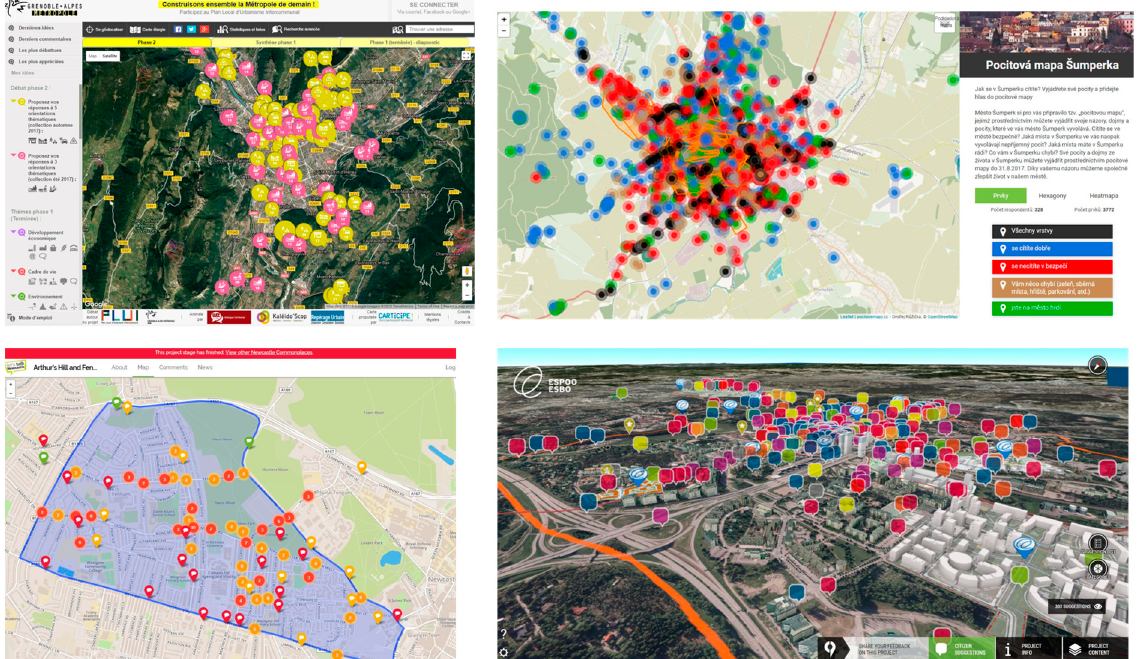
Figure 2. Screenshots of geoparticipation platforms. ( Top left ): Carticipe-Debatomap (Grenoble Metropolitan Agency, France); ( Top right ) : Emotional Maps (City of Šumperk, Czech Republic); ( Bottom left ): Commonplace (Newcastle City Council, UK); ( Bottom right ): CityPlanner (City of Espoo). Picture credits: courtesy of the platform providers.